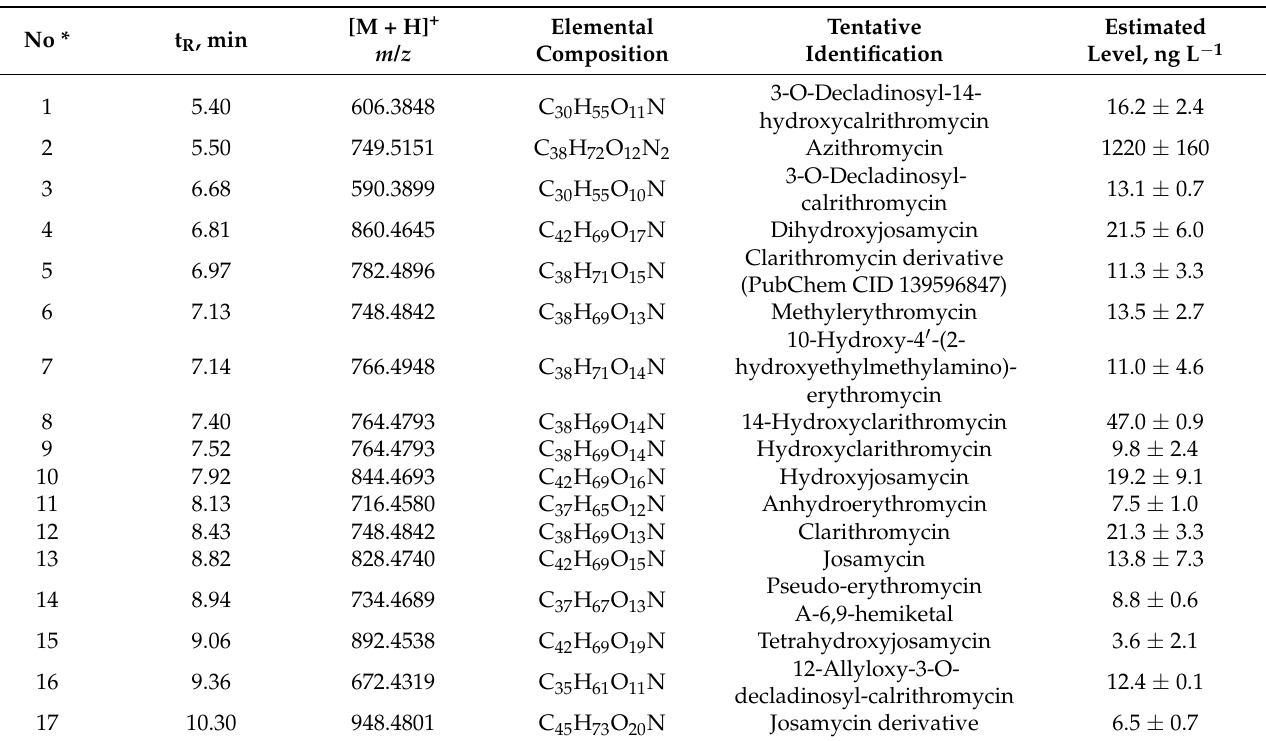
*—corresponds to the peak numbers on the chromatogram (Figure